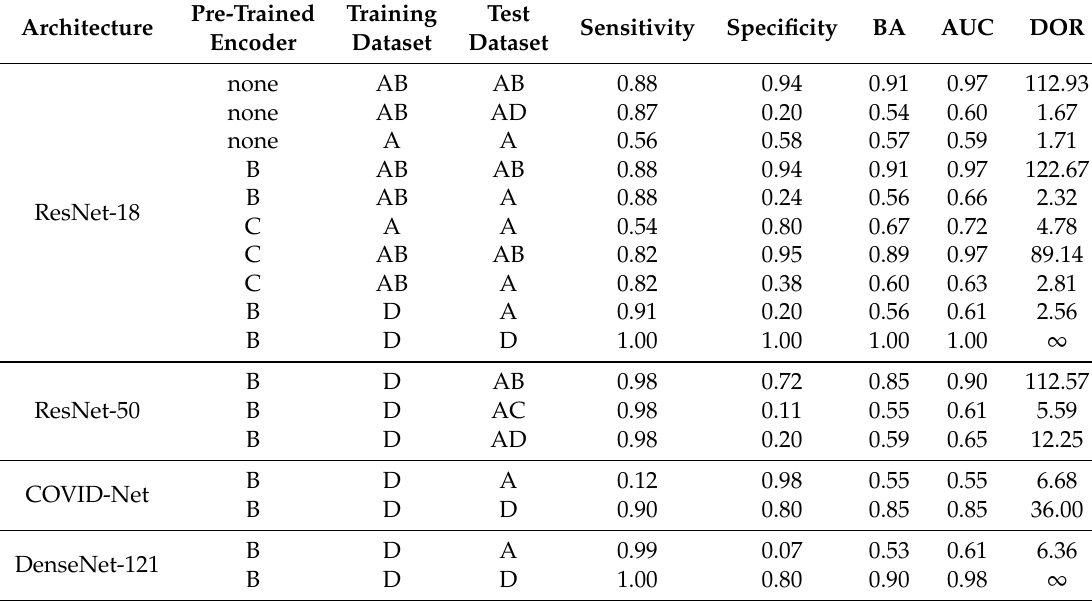
Table 2. Summary for some results obtained over a number of architectures trained on various combinations of datasets. Dataset naming follows Table